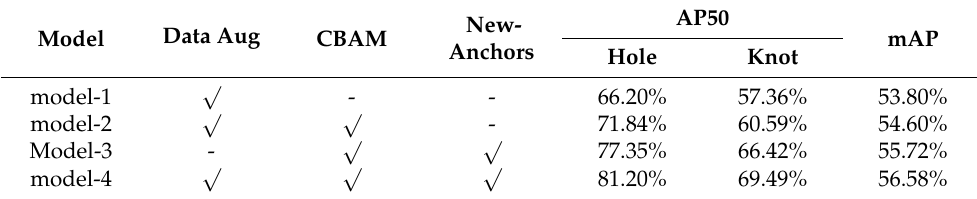
Table 4. Comparison of improved module.